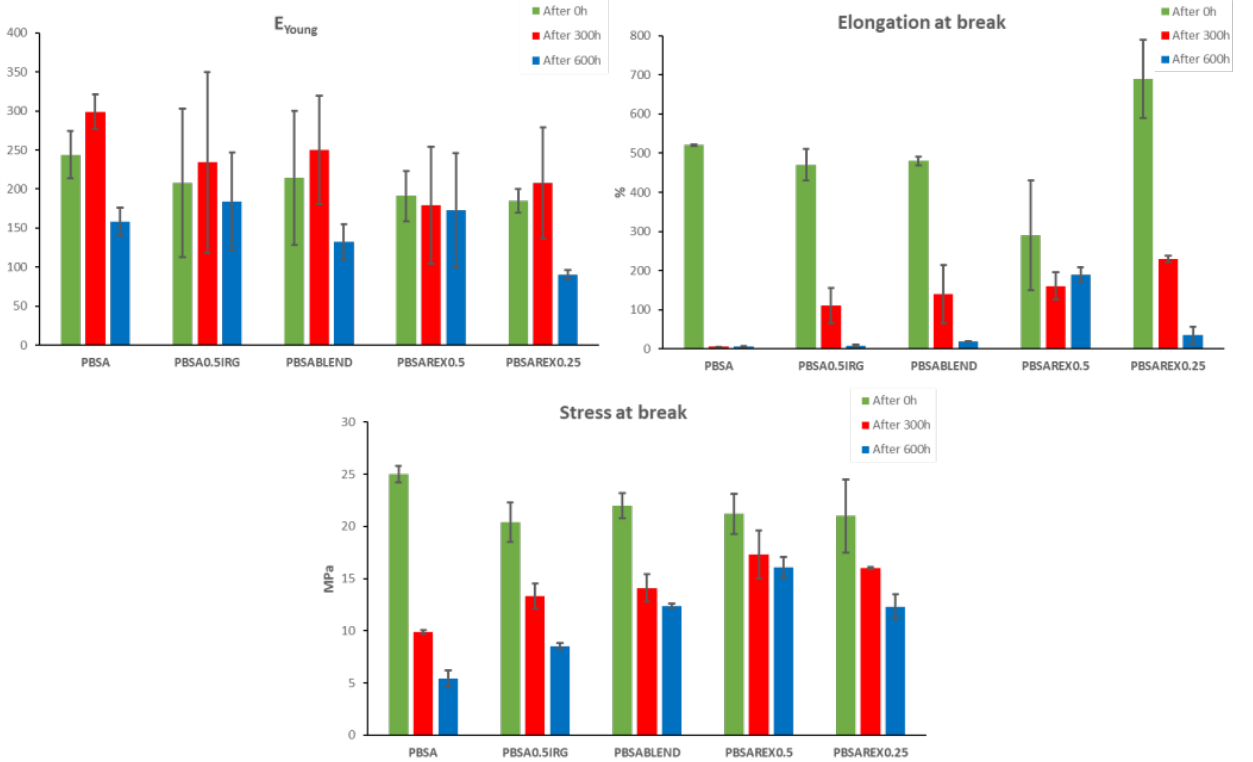
Figure 2. Graphical summary of the evolution of the mechanical performances of the samples during the aging test. Table 3. Mechanical properties of PBSA formulations at initial stage (t = 0 h) and after 300 h and 600 h of aging test. All the values here reported were obtained from the average value of 5 tests along with their standard deviation.